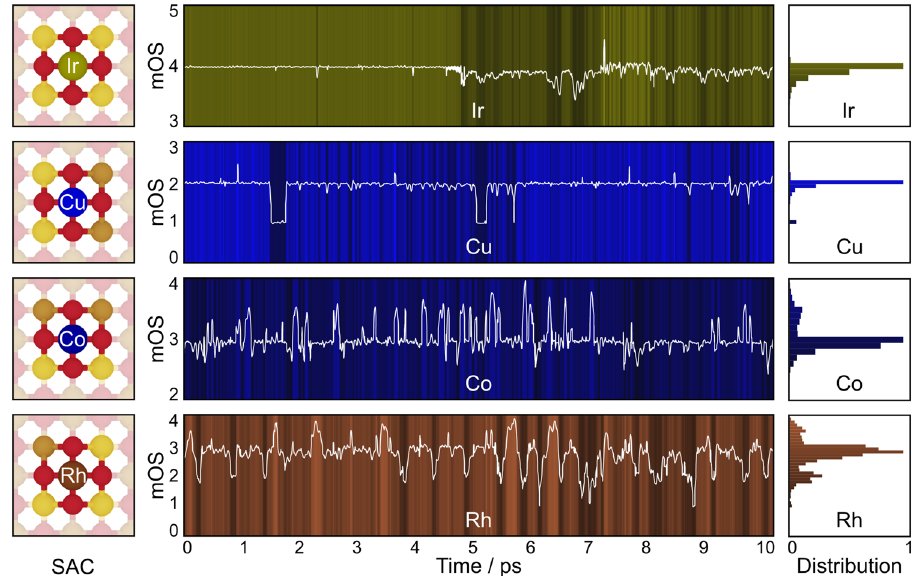
Fig. 1 Molecular Dynamics of selected CeO 2 (100)-4O-based SACs investigated for metal oxidation state (mOS) dynamics at typical working temperature (600 K). The left panels show top views of the initial, unoptimized SAC structures, with ground state Ce 3 + distributions indicated. colour code: O 2 − , red; Ce 4 + , orange; Ce 3 + , yellow (metal species annotated; one subsurface polaron for Co-4O). The center panels depict the continuous mOS progressions during the 10 ps trajectories, indicated via the white lines and background colour gradients, where brighter (darker) colour corresponds to higher (lower) mOS values. Distributions of states at mOS increments of 0.1 are shown in the right panels. The full trajectories of the BOMD simulations can be seen in the Supplementary Videos 1 –